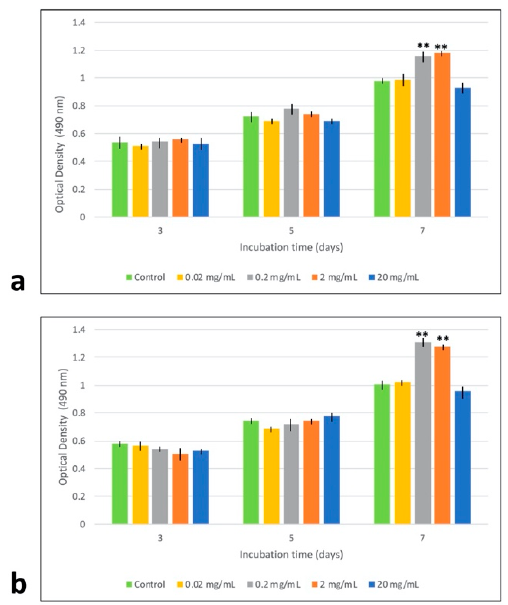
Figure 2. Investigating the effects of mineral trioxide aggregate (MTA)-conditioned media on the viability of human MSCs by MTT assay. Viability of ( a ) mesenchymal stem cells derived from bone marrow (BM-MSCs) and ( b ) human adipose-derived mesenchymal stem cells (Ad-MSCs) following treatment with different concentrations of MTA extract after 3, 5, and 7 days. At different time intervals, various concentrations of MTA-conditioned media had no cytotoxic effects on Ad/BM- MSCs. Interestingly, 7 days of incubation in 0.2 and 2 mg/mL MTA-conditioned media could induce proliferation in both cell types. Mean ± SD, n = 3, ** indicates p < 0.01. Materials 2020 , 13 , x FOR PEER REVIEW